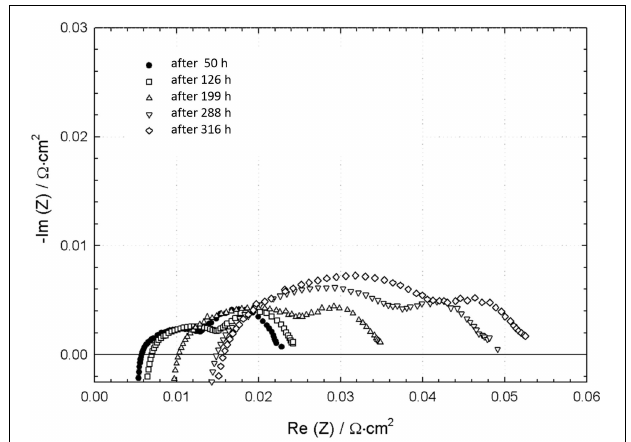
FIGURE 1 | Electrochemical impedance spectra of the reverse MCFC cell taken under an electrolysis current of 150 mA/cm 2 and at various times during the alternated period of testing (T = 650 ◦ C; fuel electrode gas composition of 25CO 2 /25H 2 O/25H 2 /25N 2 and oxygen electrode gas composition of 25CO 2 /25O 2 /50N 2 ).